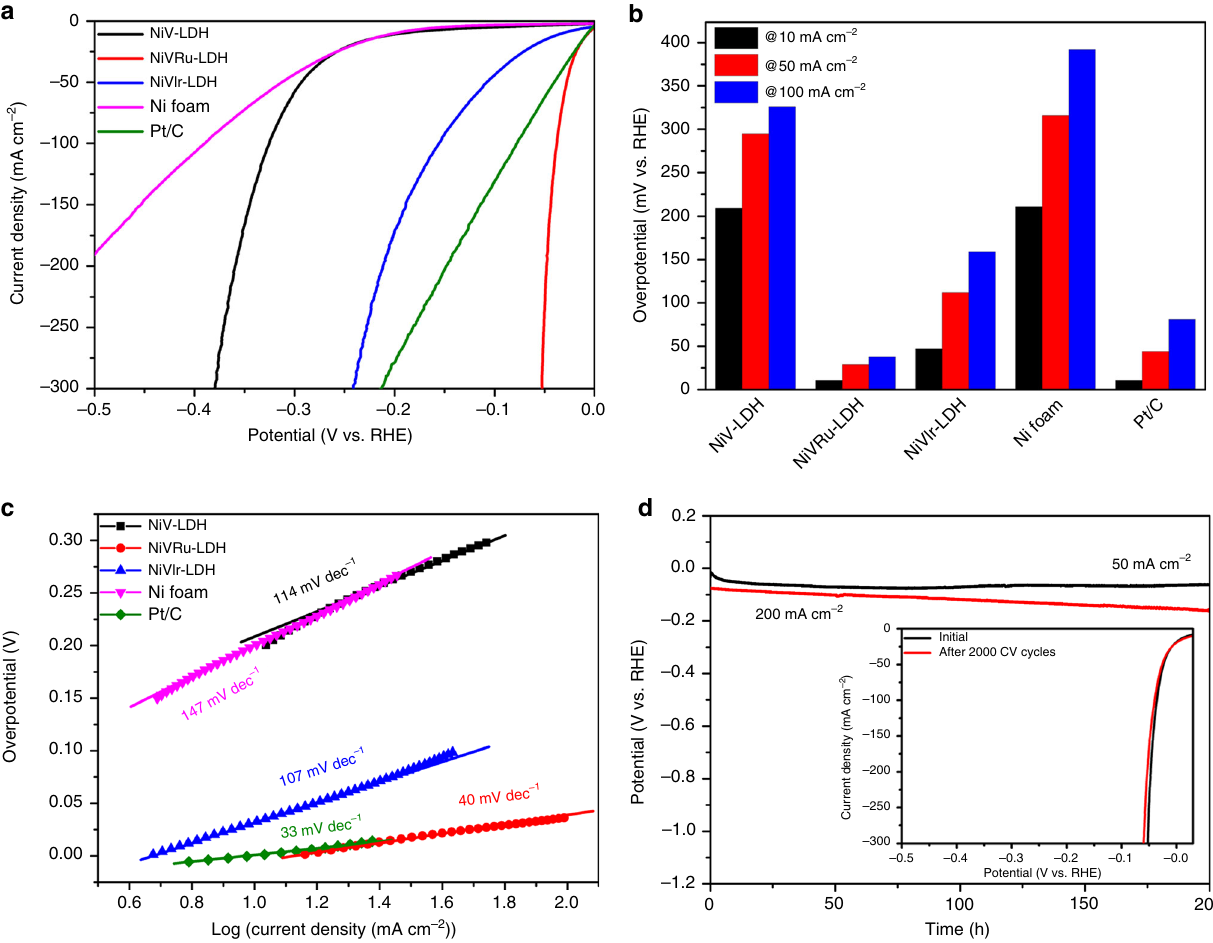
Fig. 4 HER polarization curves, Tafel plots, and long-term stability. a HER polarization curves, b the overpotentials at 10, 50, and 100 mA cm − 2 , and c the corresponding Tafel plots of the as-obtained NiV-LDH, NiVRu-LDH, NiVIr-LDH, Ni foam, and Pt/C. d The chronopotentiometric curves of NiVRu-LDH for the HER test at 50 and 200 mA cm − 2 . Inset: polarization curves of NiVRu-LDH for the durability test after 2000 CV